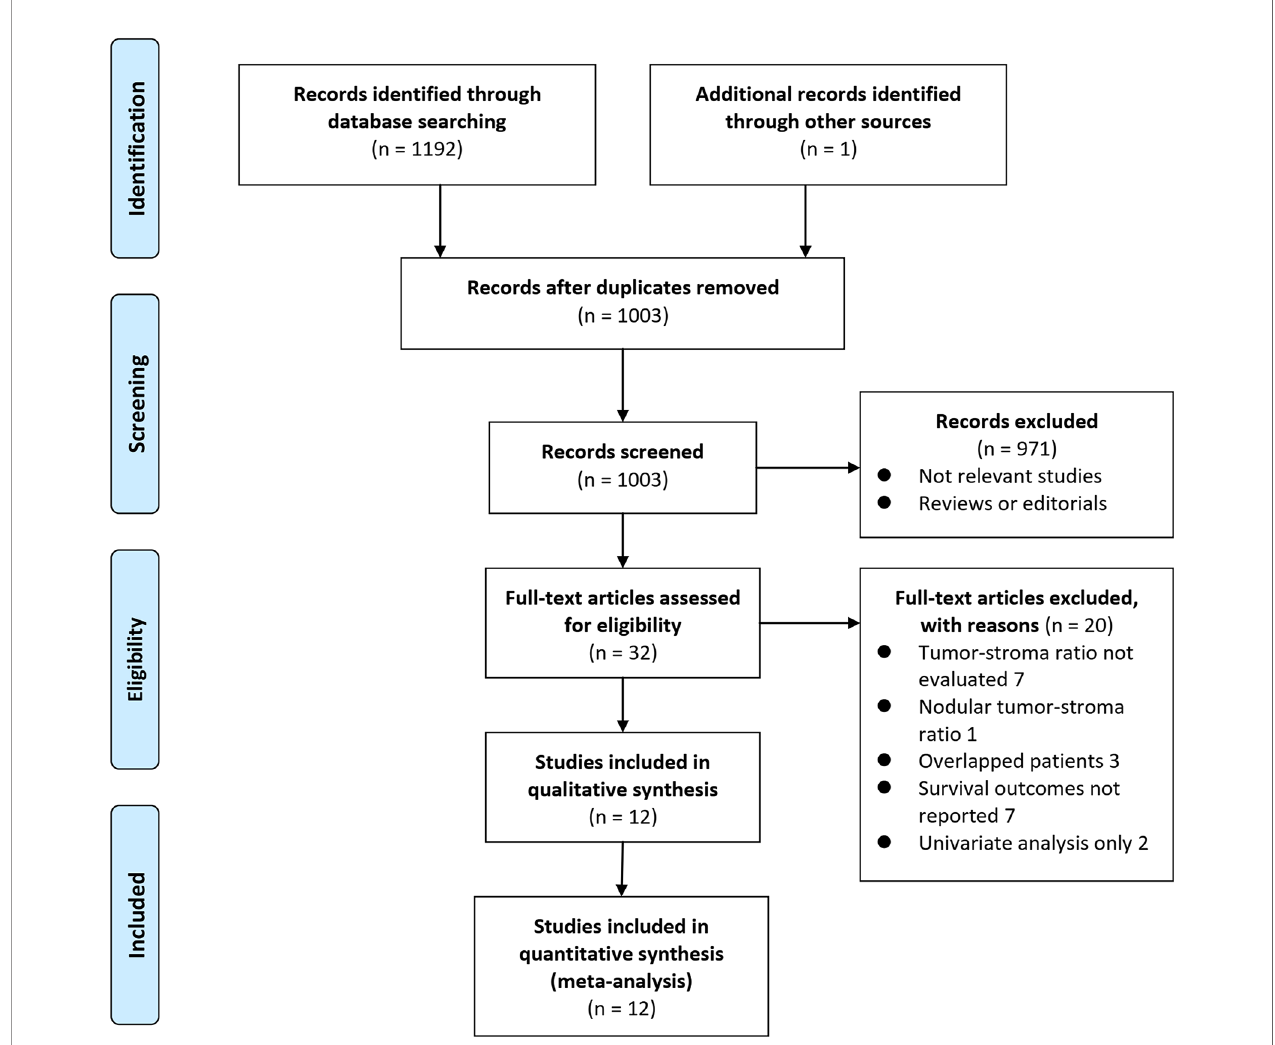
FIGURE 1 | Flowchart of literature